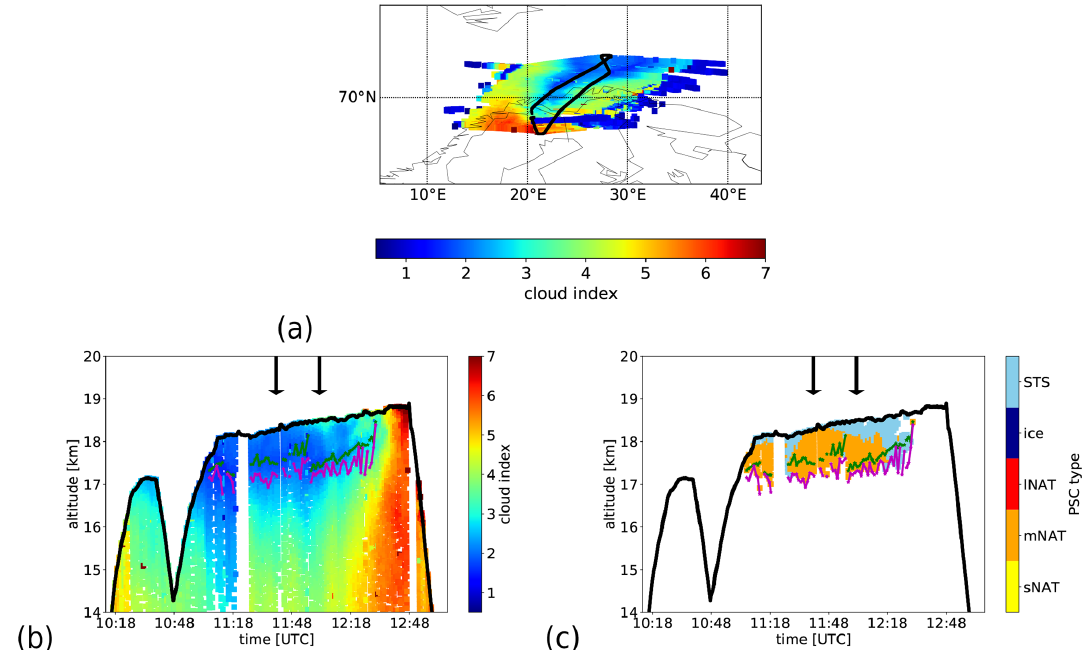
Figure 11. (a, b) Longitude–latitude and cross-section plot of the cloud index for RECONCILE flight 3. (c) Cross-section plot of the PSC types. The analysis of the PSC composition was performed for all spectra between the flight altitude and CI gradient minimum. The black line shows the flight altitude of the aircraft. The CI minimum and the CI gradient minimum are marked by a green and a magenta line respectively. Only profiles with a CI minimum below 3.0 and where both minima can sufficiently be determined are considered. The black arrows in panels (b) and (c) mark the two profiles shown in Fig. 10.